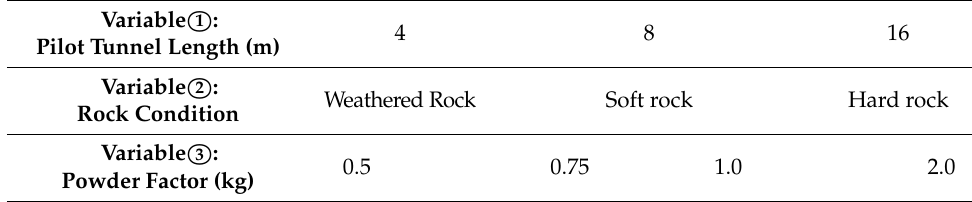
Table 7. Numerical analysis case classification.